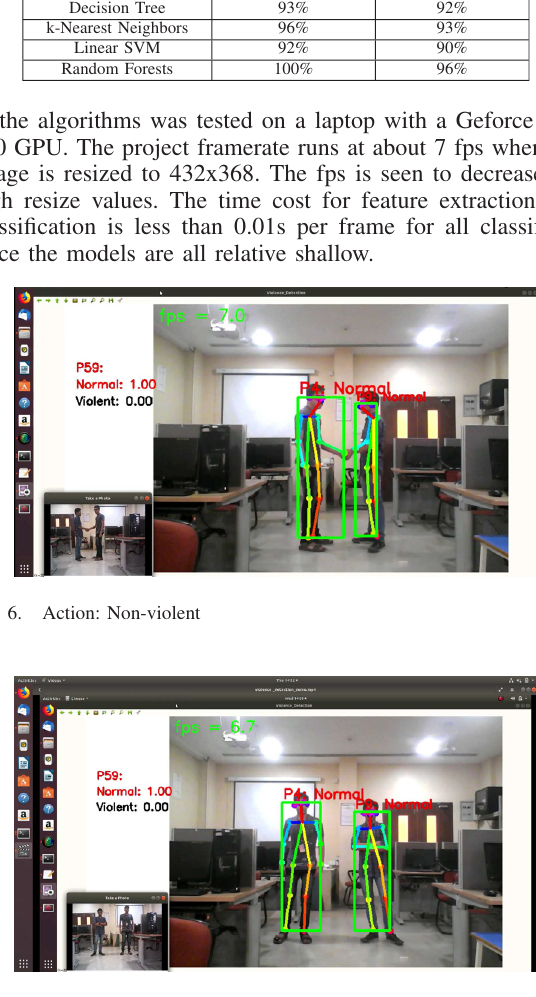
Fig. 7. Action: Non-violent